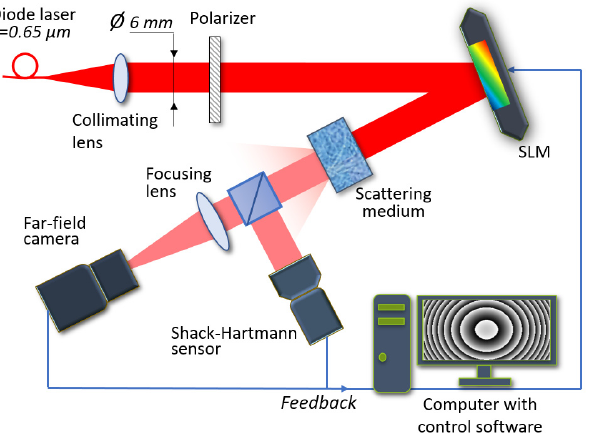
Figure 5. Scheme of the experimental setup with the SLM for laser beam focusing through a scattering medium.